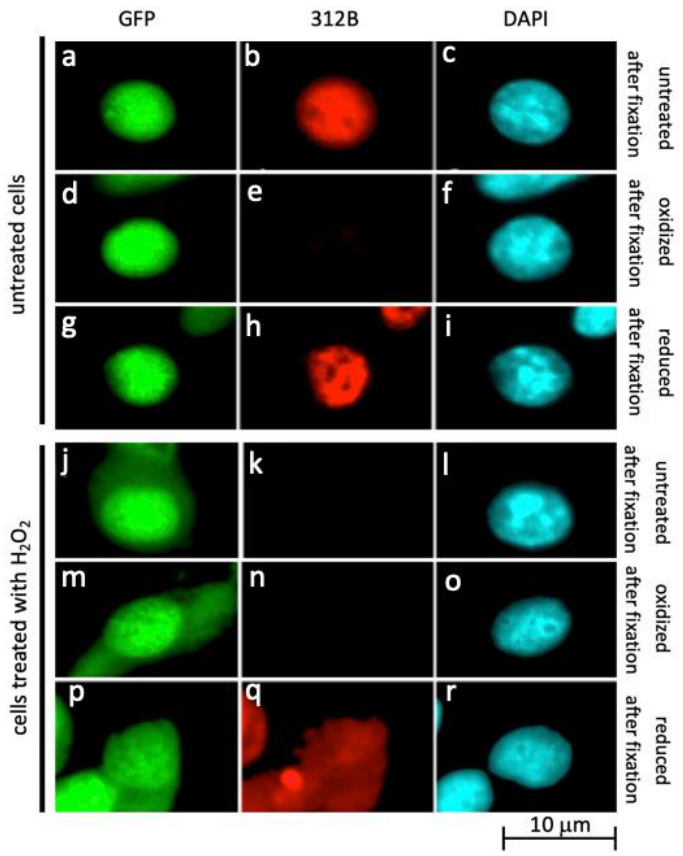
Figure 3. La protein is oxidized in the cytoplasm. ( a – q ) IF microscopy of mouse 3T3 cells overexpressing His-La-GFP ( a , d , g , j , m , p ) stained with the anti-La mAb 312B ( b , e , h , k , n , q ) or DAPI ( c , f , i , l , o , r ). ( a – c ) Untreated fixed cells. ( d – f ) Un- treated cells oxidized with H 2 O 2 after fixation. ( g – i ) Untreated cells oxidized with H 2 O 2 after fixation followed by a reduc- tion with ß-mercaptoethanol. ( j – l ) Oxidized living cells, untreated after fixation. ( m – o ) Oxidized living cells, oxidized after fixation. ( p – r ) Oxidized living cells, reduced after